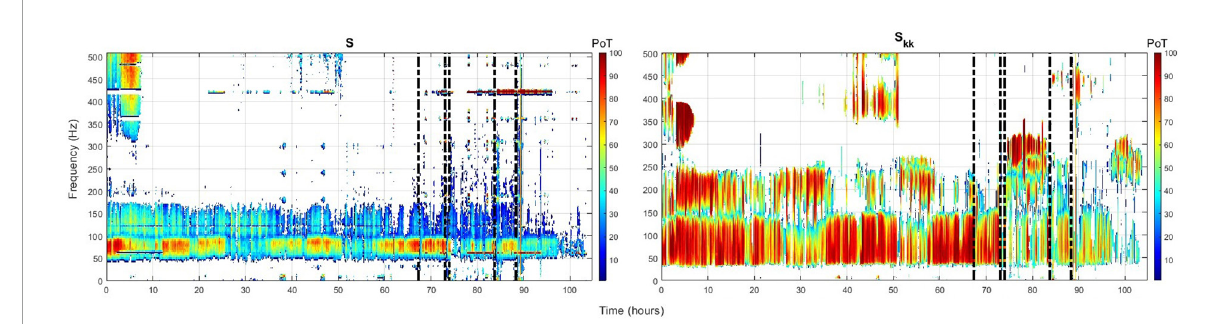
FIGURE2 Time-frequency heatmap plot of only focal channels from patient PT103 with the highest occurrence rate [highest (PoT)] for the periodogram (left) and auto-spectra (right) . Color depth represents the PoT value. Vertical dashed black lines denote the timing of the seizures.